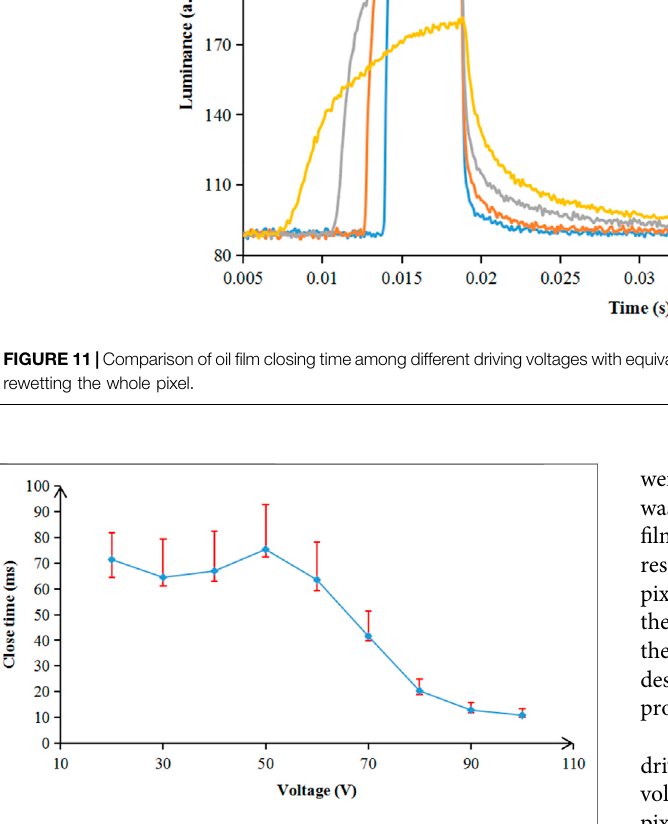
FIGURE 12 | The relationship between different driving voltages and oil fi lm closing time. The dot in the fi gure represented the closing time of the pixel when the applied driving voltage was from 20 to 100 V. The larger the driving voltage, the shorter the closing time.